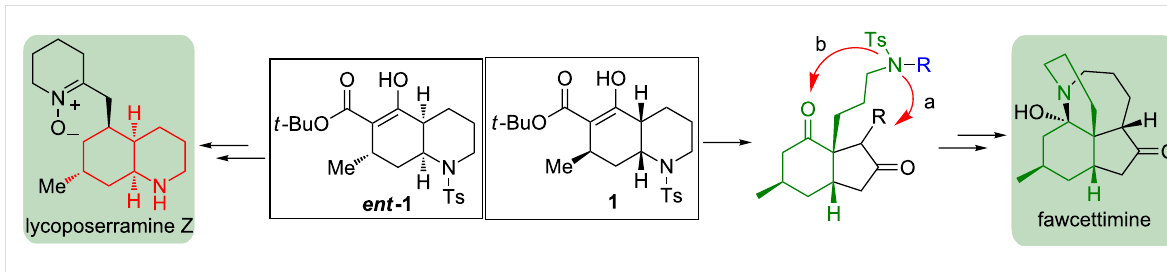
Scheme 1: Decahydroquinoline 1 as a versatile building block for Lycopodium alkaloid synthesis.